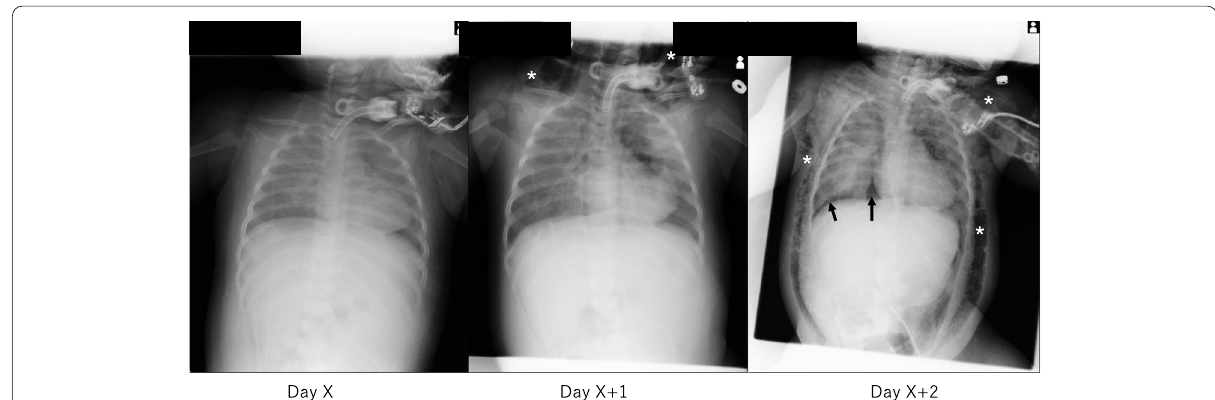
Fig. 1 Representative X‑ray images of a patient (an 8‑month‑old female with weight 5.7 kg and height 60 cm) [5]. On day X, good echocardiographic imaging was obtained; however, the image quality was slightly reduced than the day before. There was no remarkable change suggesting pneumatosis on the X‑ray image. On day X 1, good echocardiographic imaging was not obtained. Taking a closer look at the X‑ray + image, subcutaneous emphysema (asterisks) is observed around the neck. We overlooked this sign because we were distracted by the change of the X‑ray image of the left lung field. On day X 2, the patient developed severe pneumatosis. The right‑side X‑ray image shows extensive + subcutaneous emphysema (asterisks) and pneumothorax